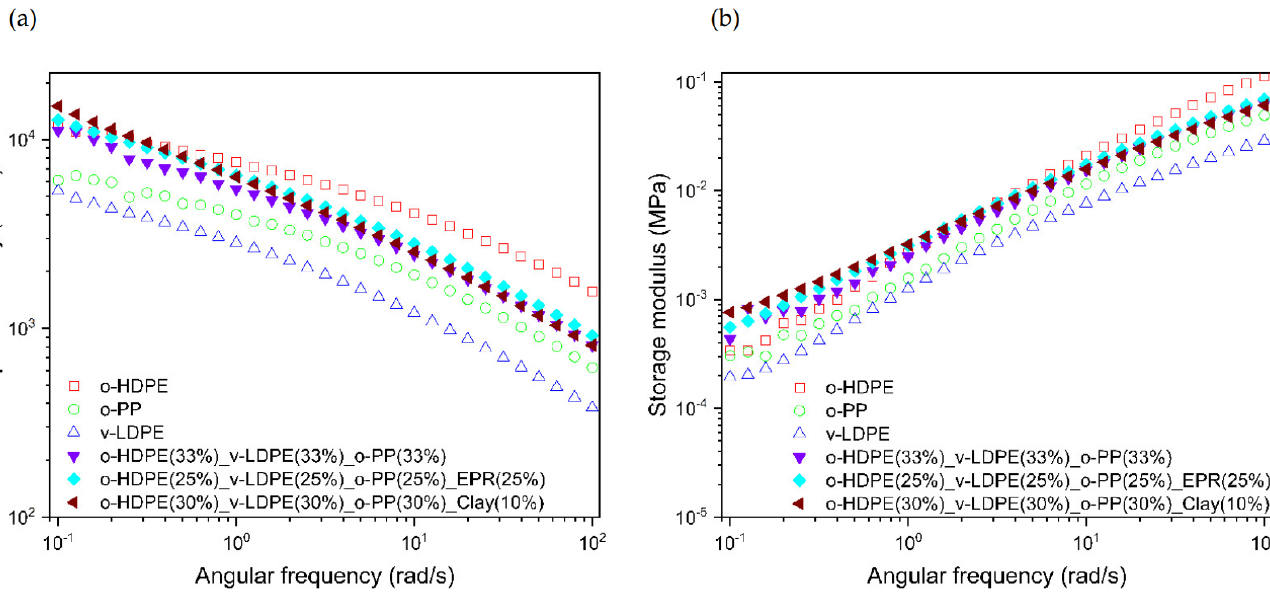
Figure 3. ( a ) Complex viscosity versus angular frequency ( b ) Storage modulus versus angular frequency.